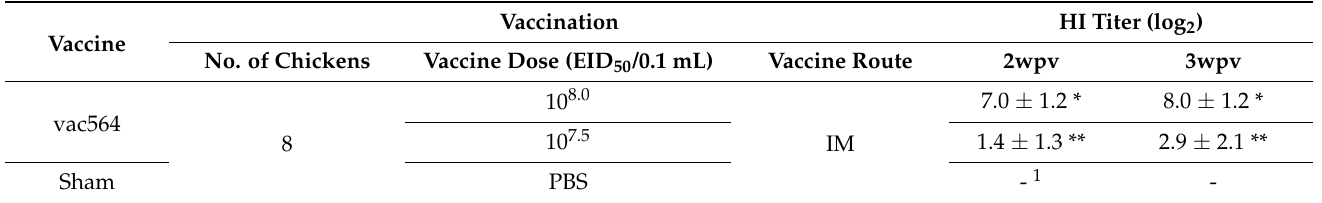
Table 2. Hemagglutination inhibition titers generated by vac564 in specific-pathogen-free (SPF) chickens.